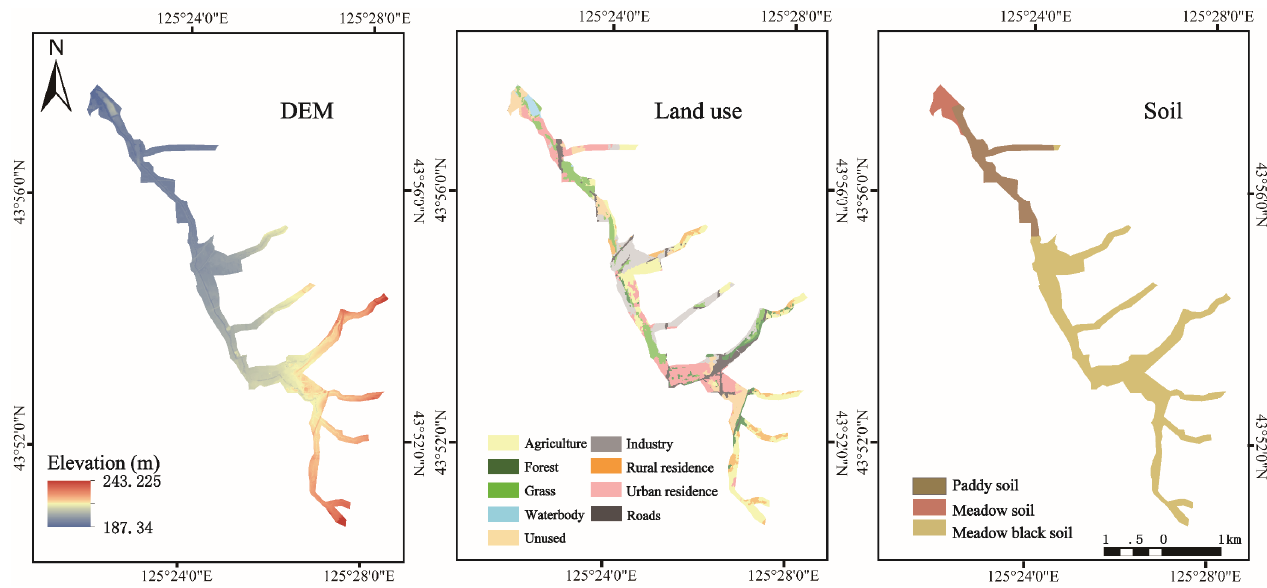
Figure 4. DEM, land use, and soil type map of DX river construction area. Table 2. Data sources and a detailed description.